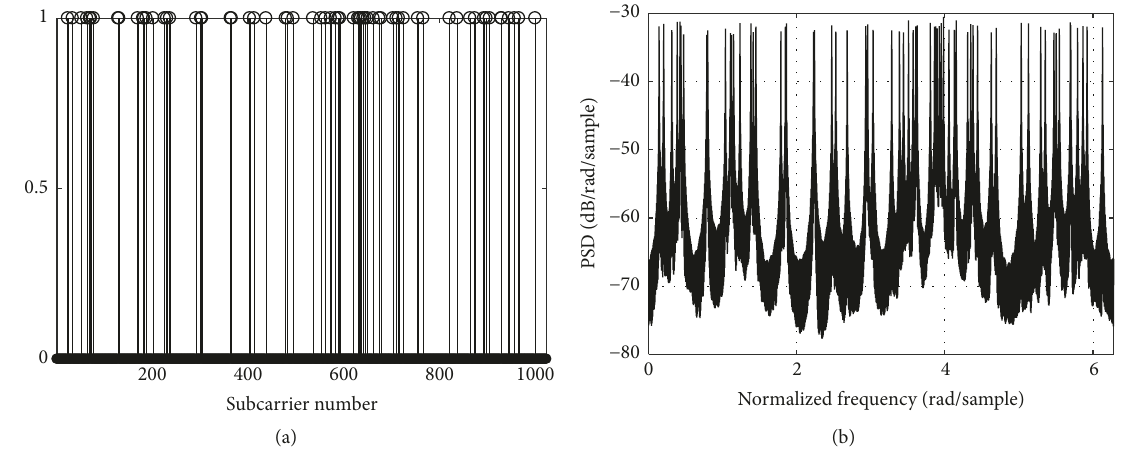
Figure 3: (a) Uniform random subcarrier allocation; (b) power spectrum density (PSD) of the transmitted